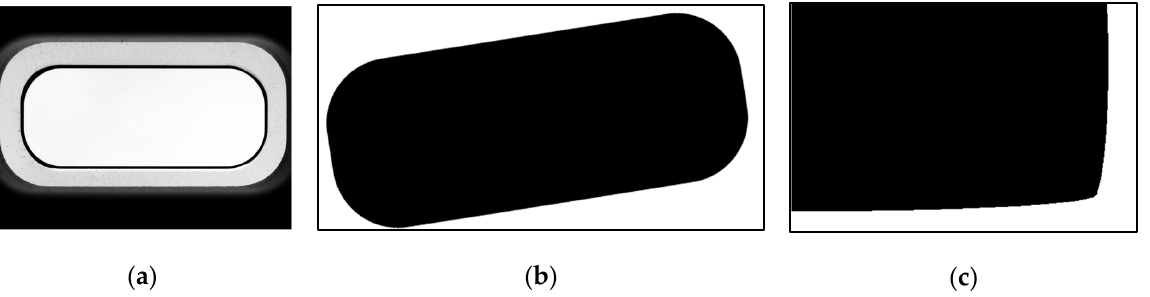
Figure 5. Targets for alignment correction: ( a ) smartphone hole; ( b ) object with curved and linear components; ( c ) object with curved components.